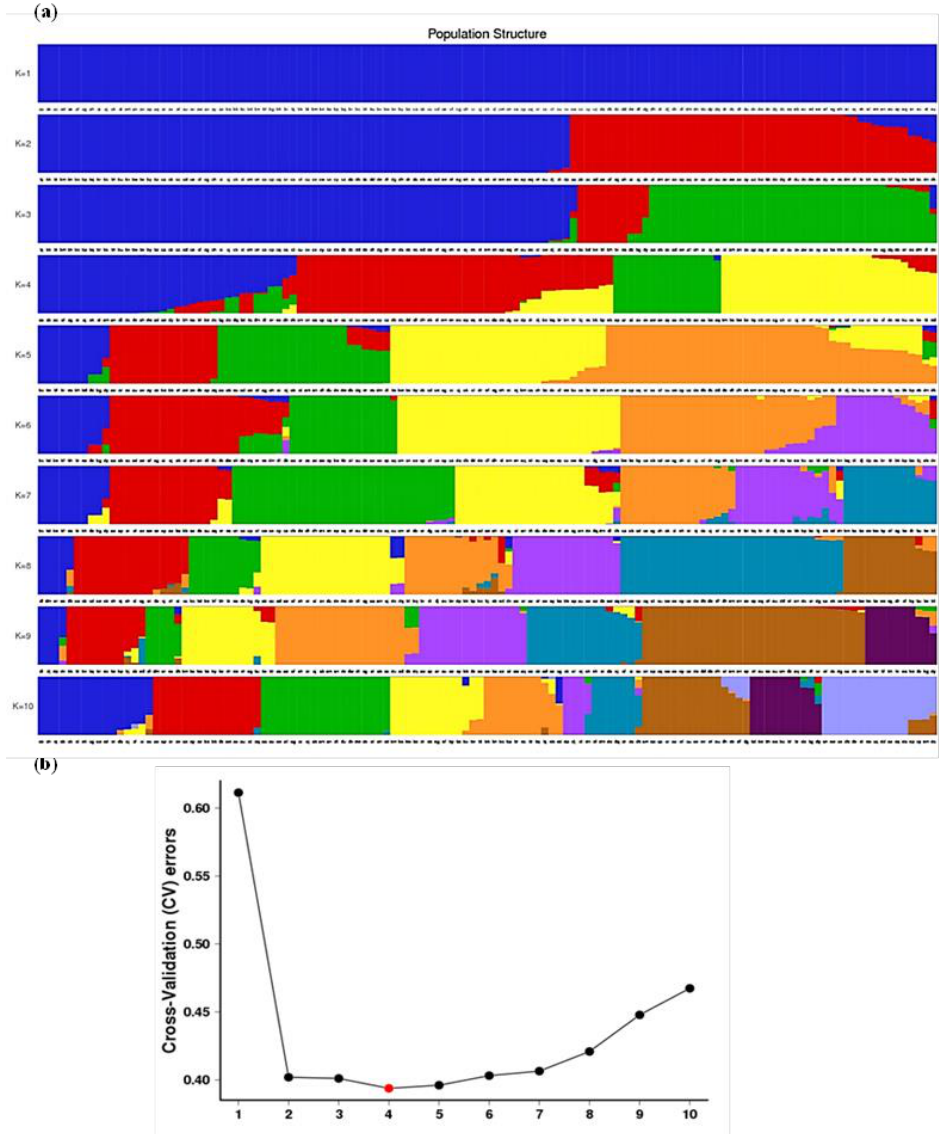
Figure 4. Population structure analysis and cluster cross-validation error analysis of 125 ancient tea samples. ( a ) The horizontal coordinates represent 125 ancient tea samples in order, and the vertical coordinates represent the number of subgroups K values (K = 1–10). Different colors represent subgroups with different gene frequencies in the 125 ancient tea plant samples, and ancient tea plants in the same subgroup are closely related. The color corresponding to each sample and the color proportion represent the subgroup this sample belongs to and the proportion of the source of genetic material. ( b ) The x-axis represents the K-value (1–10), and the y-axis is the cross-validation error values.